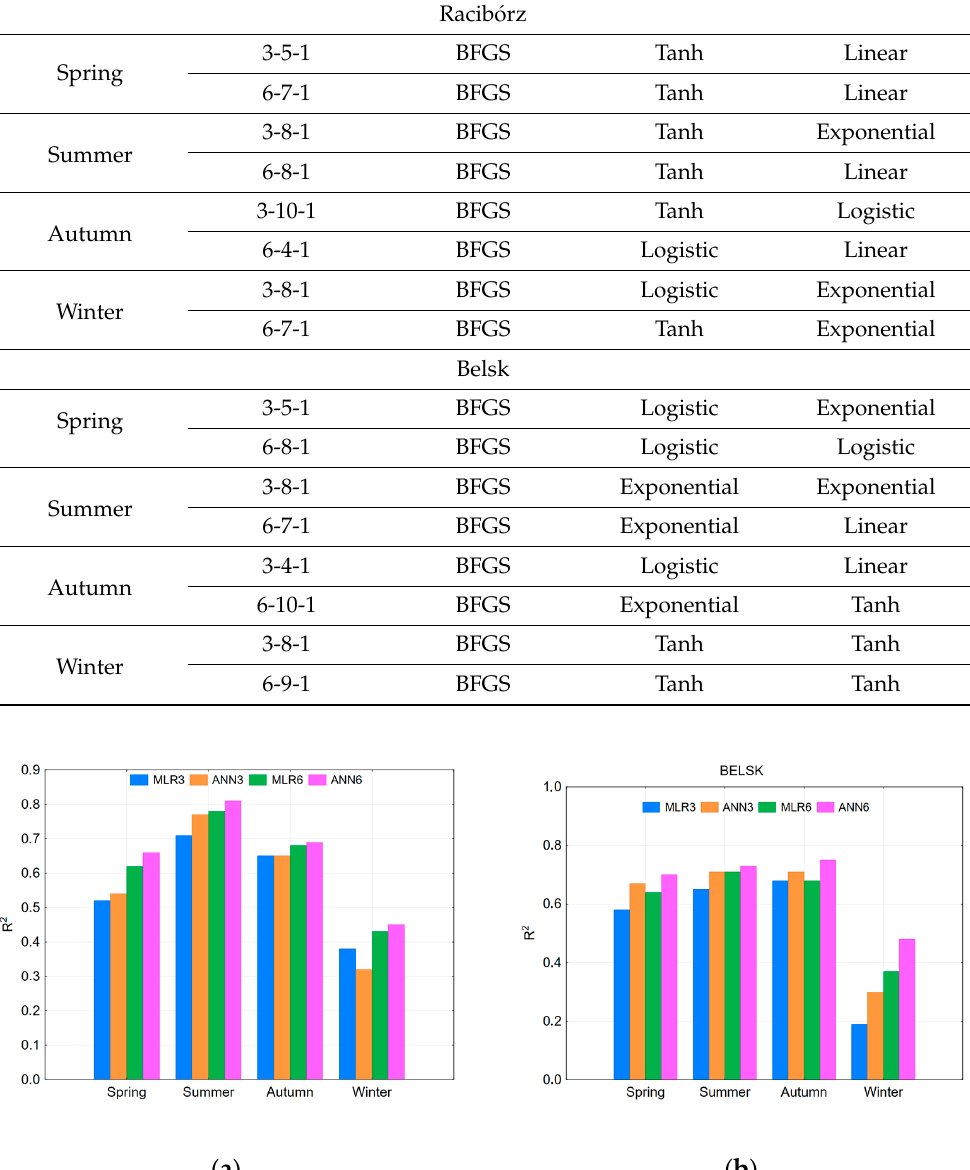
( b ) Figure 9. The same as Figure 8 but for mean bias error (MBE) for Racibórz ( a ) and Belsk ( b ). Figure 10. The same as Figure 8 but for mean absolute error (MAE) for Racibórz ( a ) and Belsk ( b ).